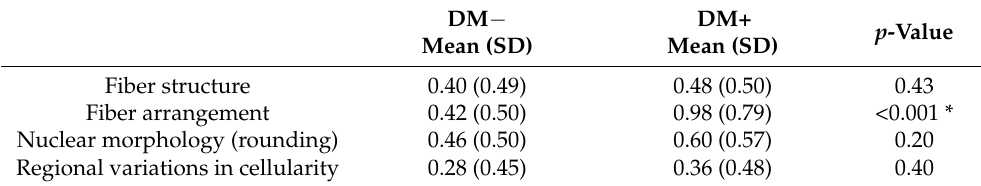
Table 3. Pathological score of tendons by hematoxylin and eosin staining.